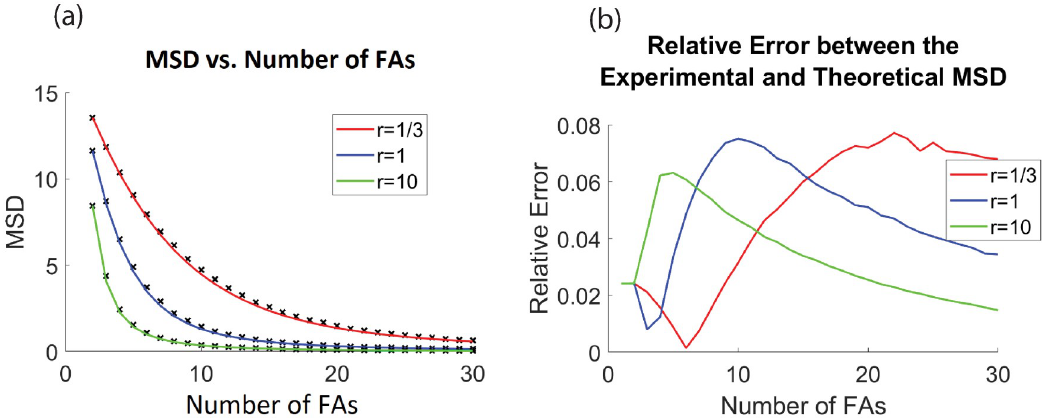
Fig 4. Comparison between the experimental MSD and the estimated theoretical MSD. For the left panel, the experimental MSD ( TAMSD 2 ) is computed from a simulated trajectory of 10,000,000 points and is marked with a black “x” for different values of FAs. It is compared to the AMSD found in Eq (13), given by the solid lines. The right panel shows the relative error between TAMSD 2 and AMSD for different values of r . For this simulation and all reported simulations the angle of η (the outreach vector) is from -30 to 30 degrees, and the length of η is from 0 to 10. The centroid model is a space and time homogeneous process, thus TAMSD 2 � MSD